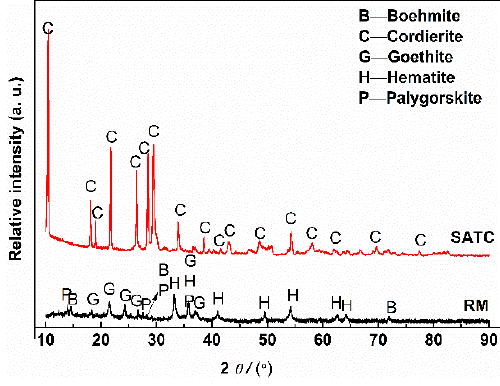
Figure 1. XRD patterns of SAC and